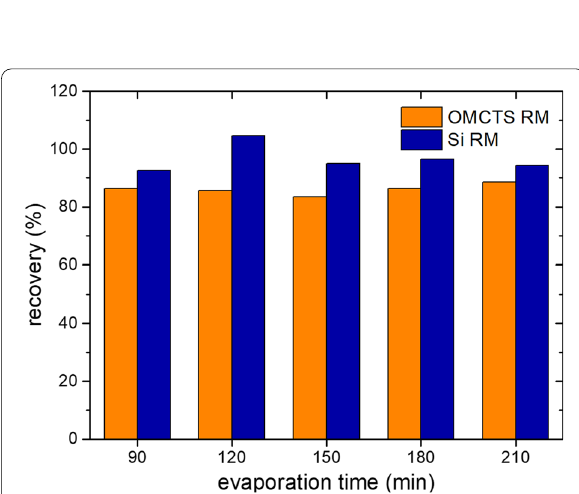
Fig. 6 Recovery with different evaporation times in OMCTS RM and Si